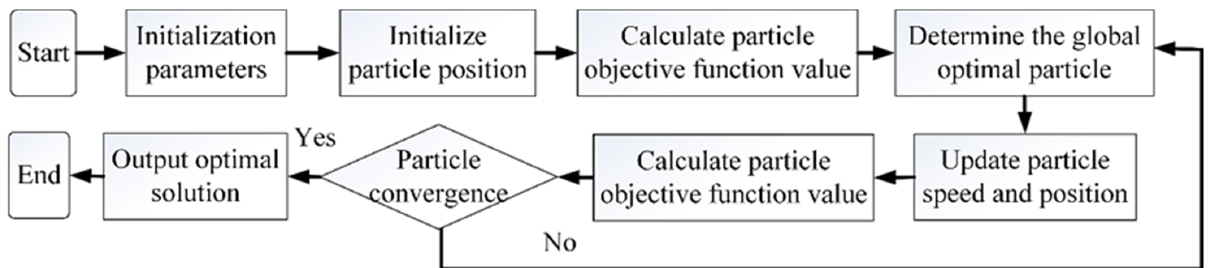
Figure 6. Flow chart of particle swarm optimization algorithm.